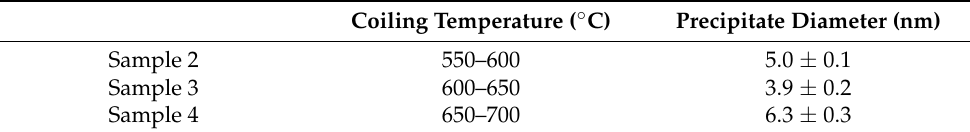
Table 3. Mean precipitate diameters for the different coiling temperatures.